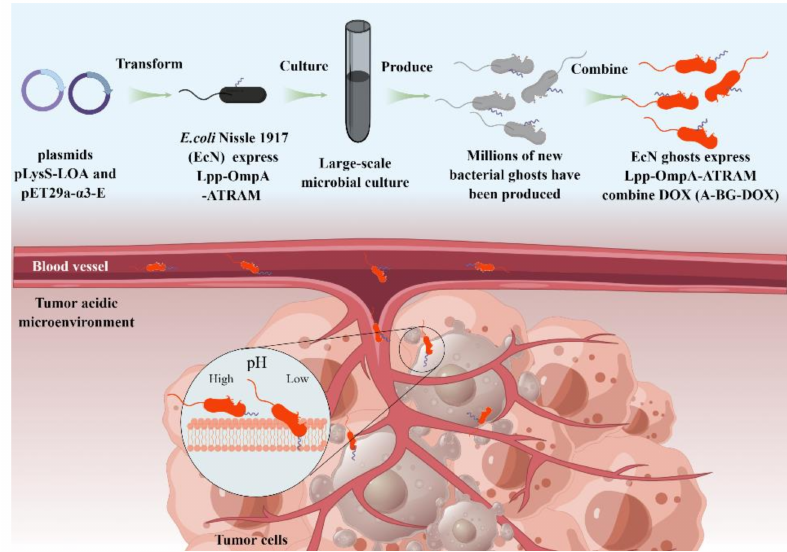
Scheme 1. Illustration of large-scale production of and tumor targeting by A-BG-DOX, a pH- responsive bacterial ghost for killing tumor